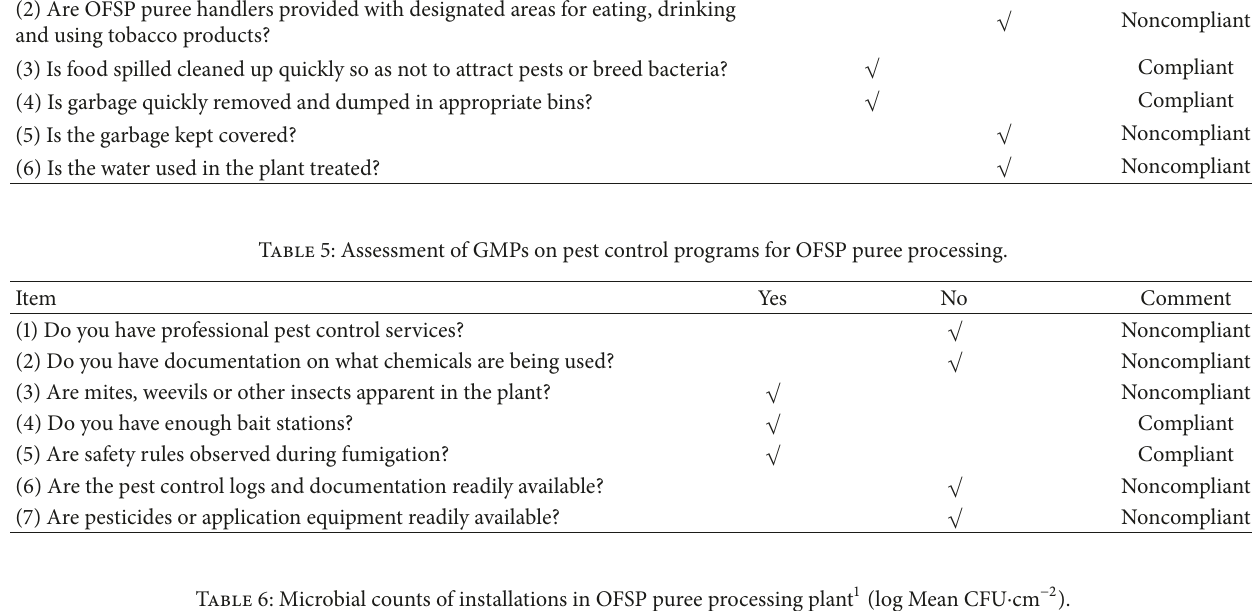
Table 4: Good Manufacturing Practices assessment for sanitary facilities in puree processing. Item Yes